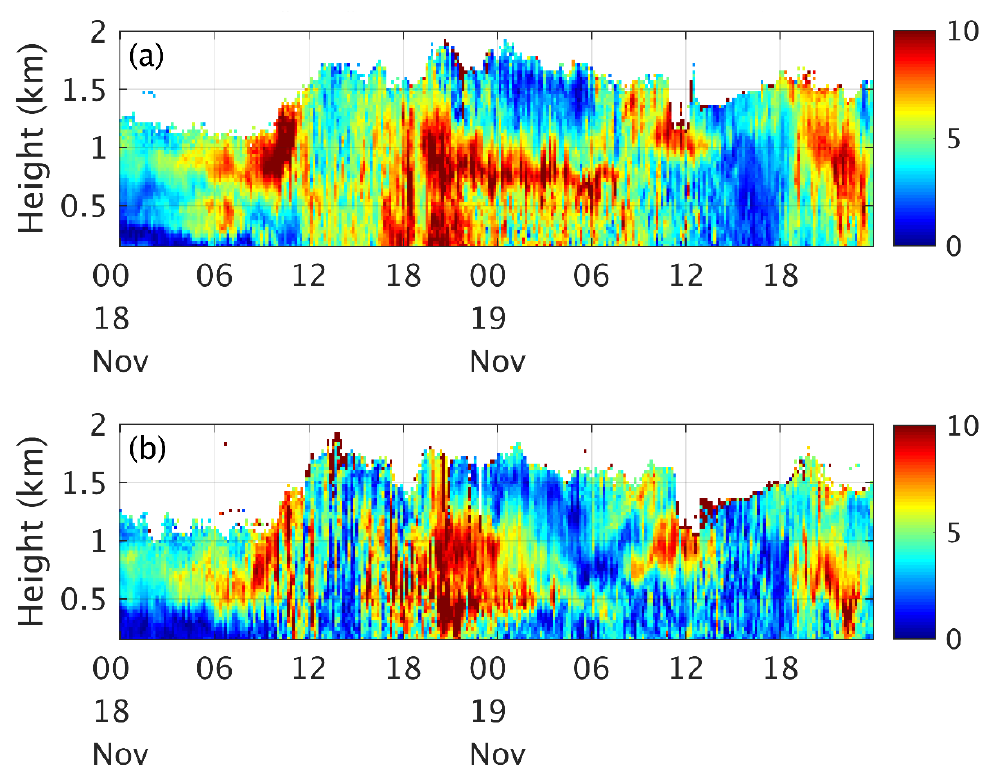
Figure 14. The high-temporal-resolution (10 minutes) vertical profiles of horizontal wind speed (m/s) at the (a) CUHK and (b) KP LiDAR sites.